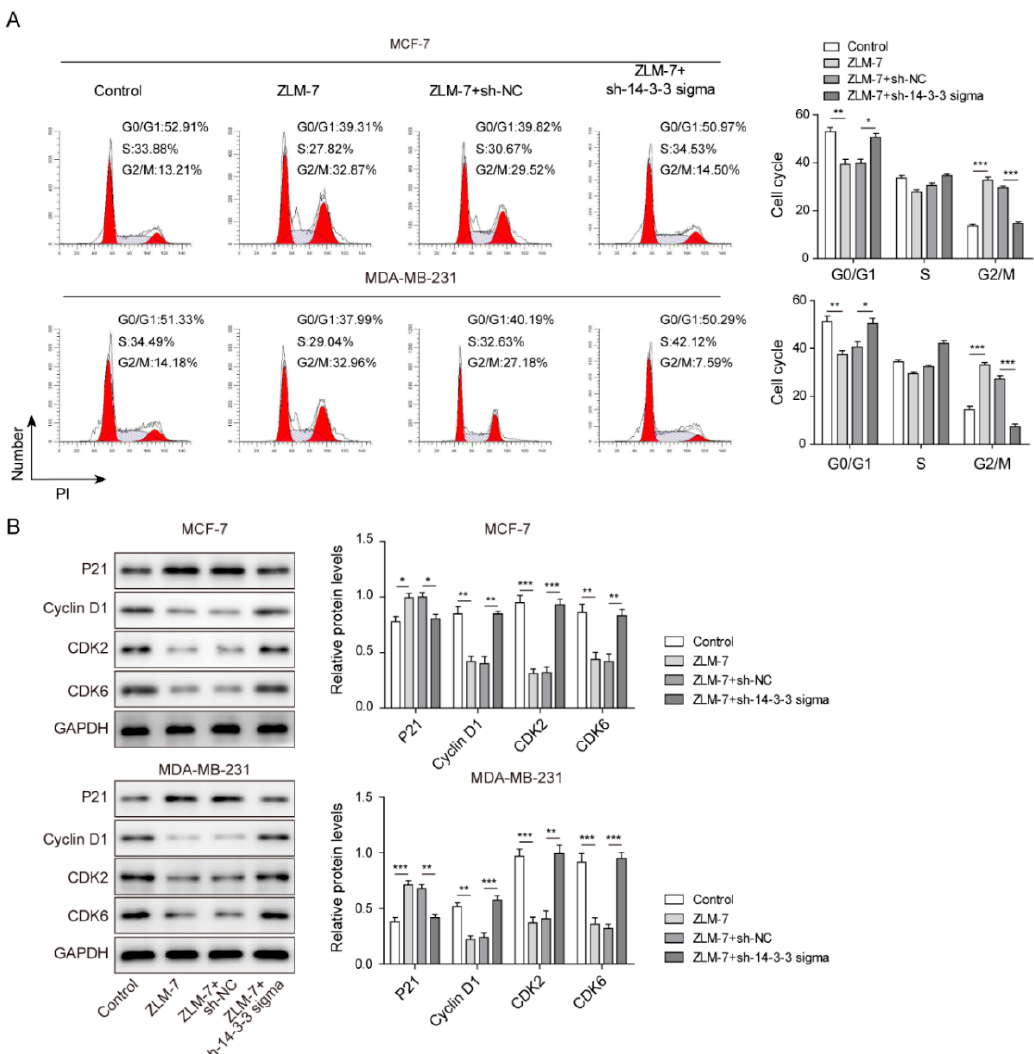
Figure 3. ZLM-7 blocked cell-cycle progression via upregulating 14-3-3 sigma. ( A ) Cell-cycle analyzed via flow cytometry. ( B ) Relative protein levels of cell-cycle regulatory proteins measured by Western blotting. MCF-7 and MDA-MB-231 cells transfected with either sh-NC or sh-14-3-3 sigma were treated with ZLM-7 for 8 h. * p < 0.05, ** p < 0.01, *** p < 0.001.